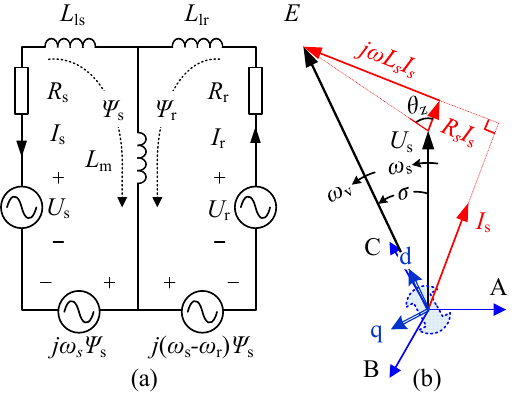
Figure 1. ( a ) Equivalent circuit of a DFIG in dq reference frame; ( b ) Voltage vector diagram. The magnetic linkage equation is: